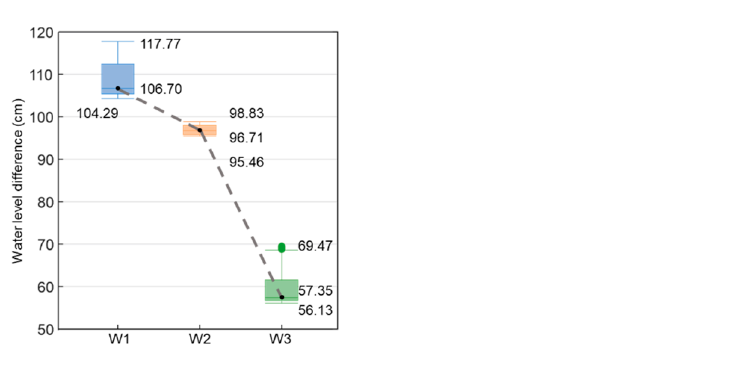
Figure 11. Analysis of seepage using water level data from the water gauge and monitoring data from the sensors in the earth dam seepage test.